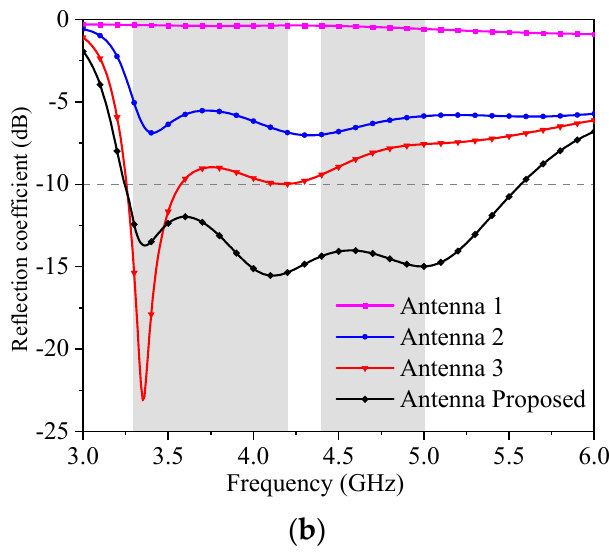
Figure 2. Design development and S-parameters of antenna unit: ( a ) the design evolution; ( b ) simulated S 11 .